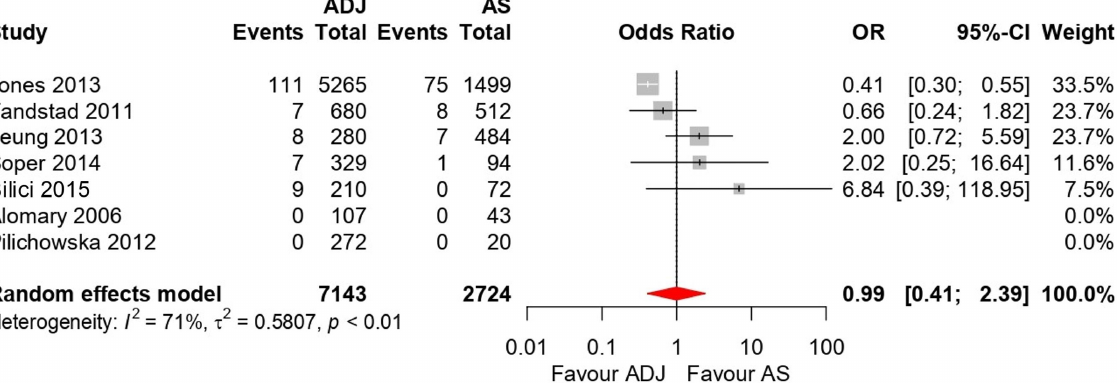
Figure 3. Forest plots for 5-year overall survival (OS) comparing active surveillance (AS) and adjuvant therapy [12,14,16,20,21,23,24]. There was no significant difference between AS and adjuvant therapy in 5-year OS (odds ratio, 0.99; 95% confidence interval, 0.41–2.39; p = 0.97).